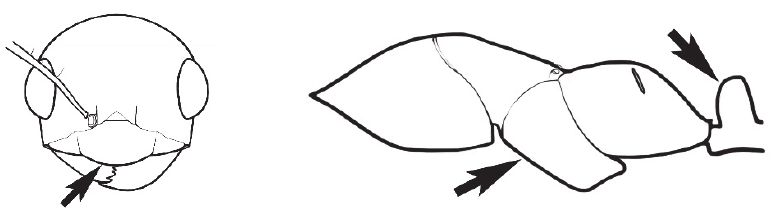
arid) ( JDM 699 ) (Fig. 74a–d) ........................................... vitreus (‘ pillipes ’)